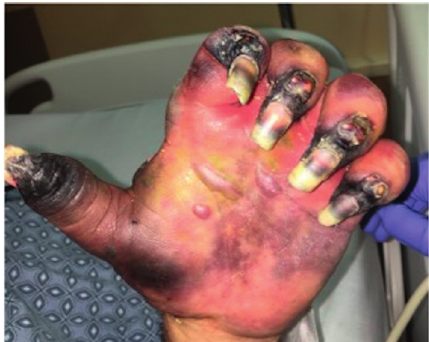
Figure 1: Patient’s hand on initial presentation.